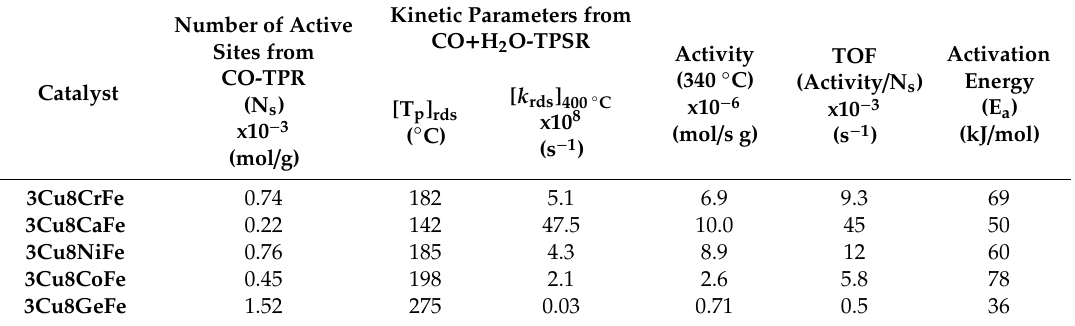
Table 1. Number of catalytic active sites (N s ), the CO 2 evolution peak reduction temperatures ([T p ] rds ), reaction rate constants, [ k rds ] 400 ◦ C from [T p ] rds , SS-WGS activity, TOF and activation energy values of